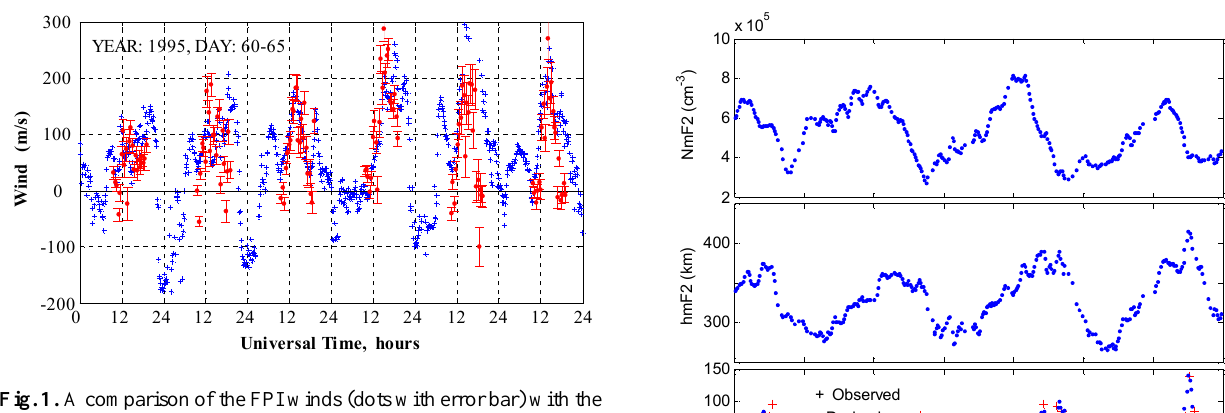
Fig. 1. A comparison of the FPI winds (dots with error bar) with the equivalent winds deduced from digisonde measurements (‘+’) dur- Fig. 1 A comparison of the FPI winds (dots with error bar) with the equivalent winds ing 1–6 March 1995, in Beveridge, Australia (See Dyson et al., 1997 for a detailed description of the campaign and their hm F2 winds de- deduced from digisonde measurements (‘+’) during March 1-6, 1995, in Beveridge, rived with the servo method). Australia (See Dyson et al. (1997) for a detailed description of the campaign and their hmF2 winds derived with the servo method).